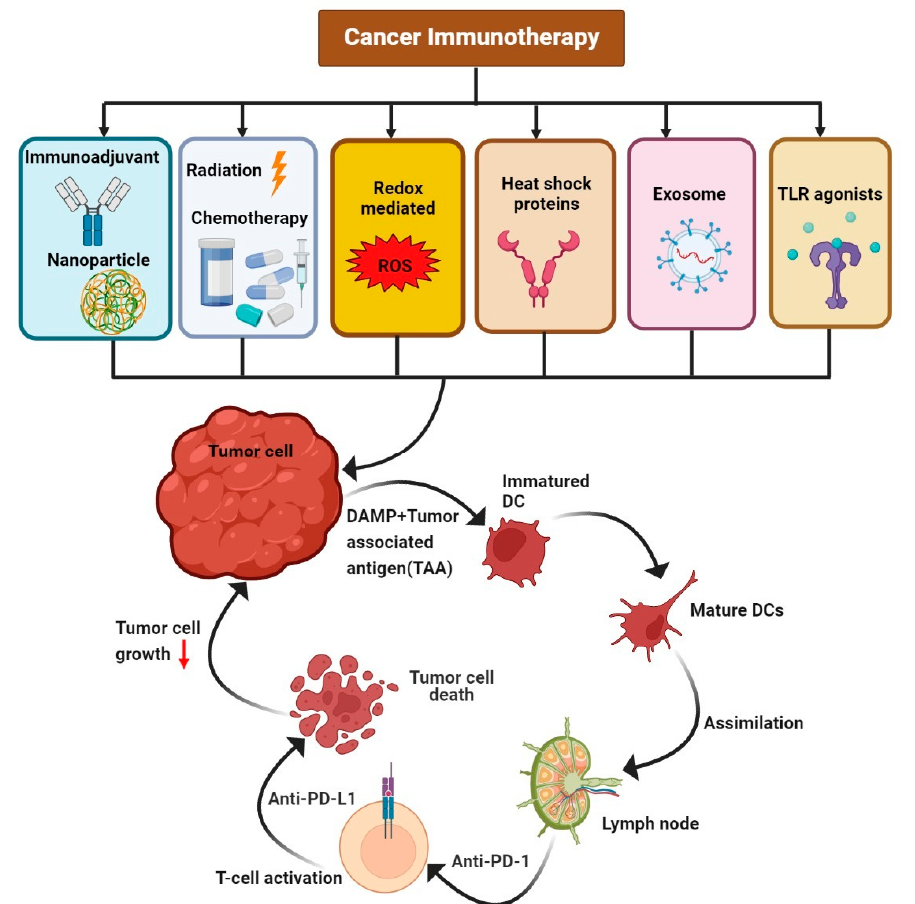
Figure 1. The various available immunotherapy treatments, such as immunoadjuvants with nanoparticles, radiation, chemotherapy, redox-mediated therapy, heat-shock proteins, exosomes, and TLR agonists, that act upon tumor cells, leading to the activation of T cells and suppressing tumor cell growth.